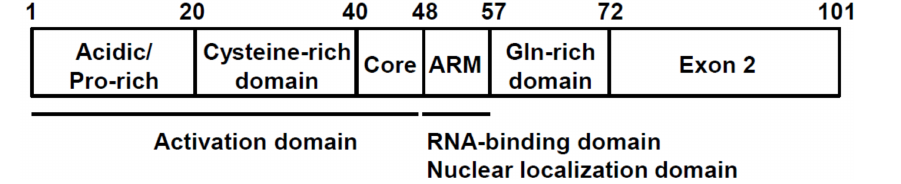
Figure 2. Tat functional